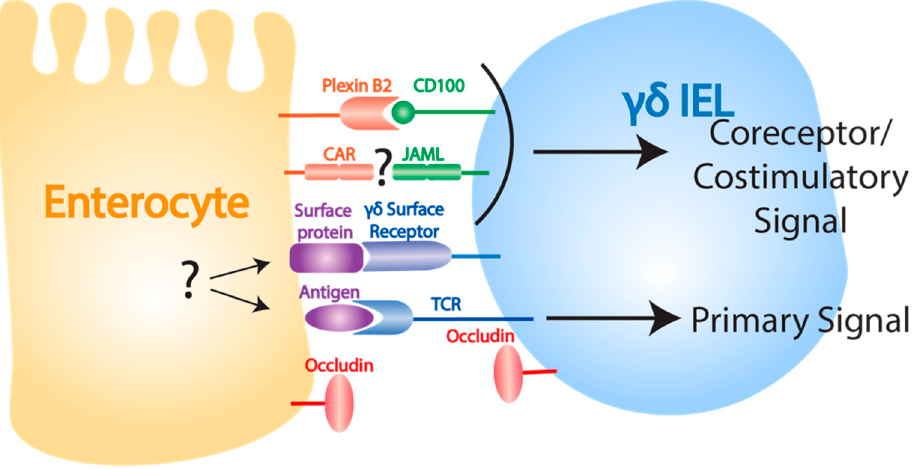
Figure 2. Ligands involved in γδ IEL function. The mechanisms behind γδ IEL activation following intestinal epithelial damage are less well understood than the mechanisms underlying DETC activation in the skin, but plexin B2-CD100 interactions are known to play a role. Intestinal epithelial cells and γδ IELs express CAR and JAML, respectively, but whether these interactions provide a costimulatory signal following epithelial damage is unknown. The role of antigen recognition by TCR and the presence of other costimulatory signals also remain unknown. Occludin expressed by both γδ IELs and intestinal epithelial cells is important for γδ IEL